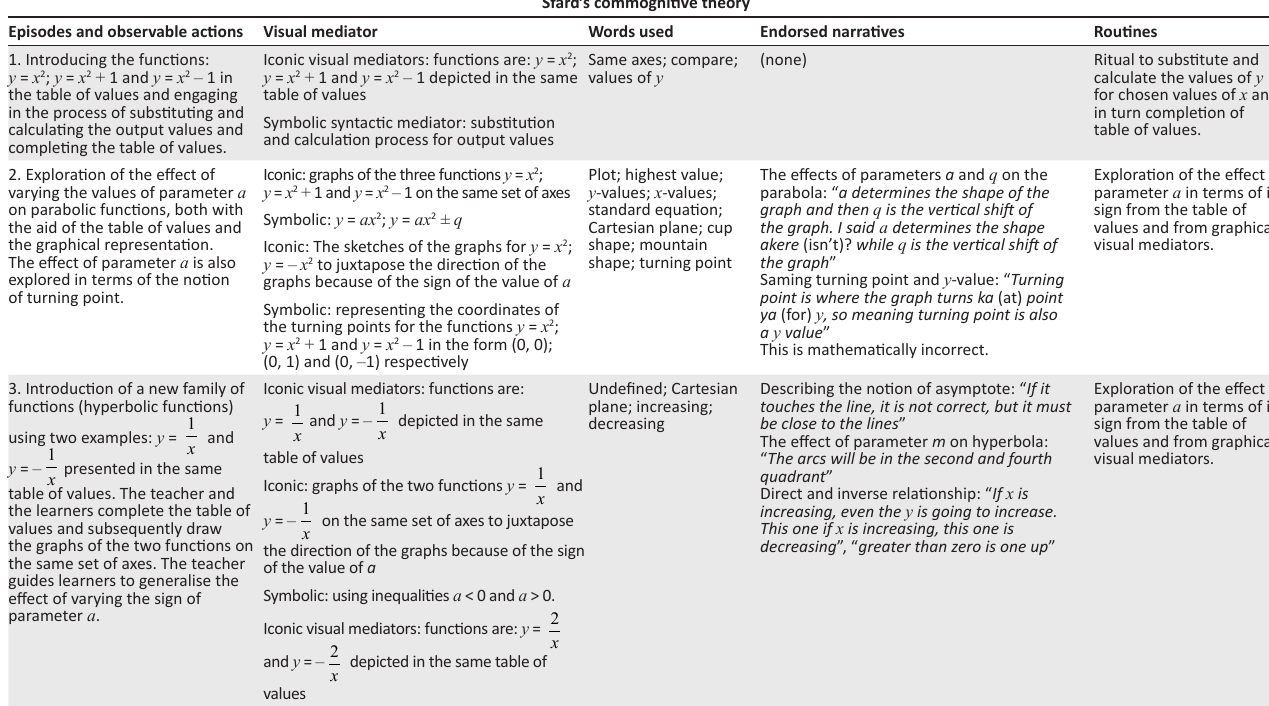
Sfard’s commognitive theory